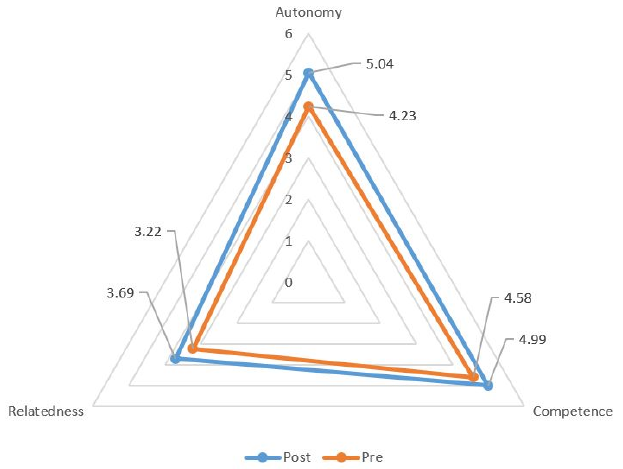
Figure 8. Perceived pre- and post-levels of autonomy, competence, and relatedness.